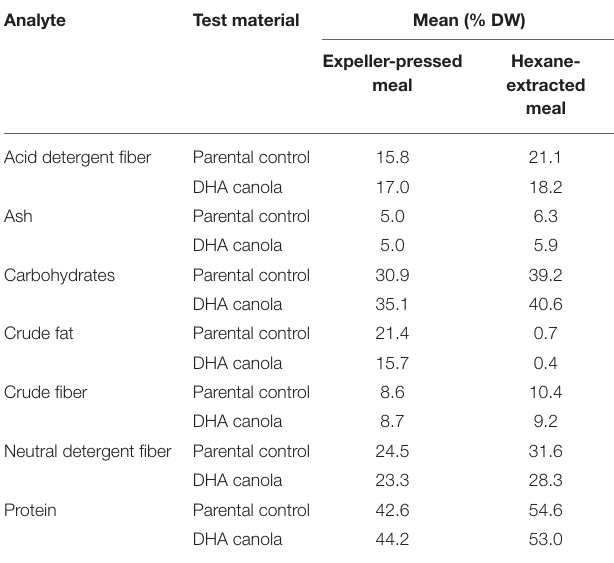
TABLE 3 | Proximate of expeller-pressed and hexane-extracted DHA canola meal (% DW). Analyte